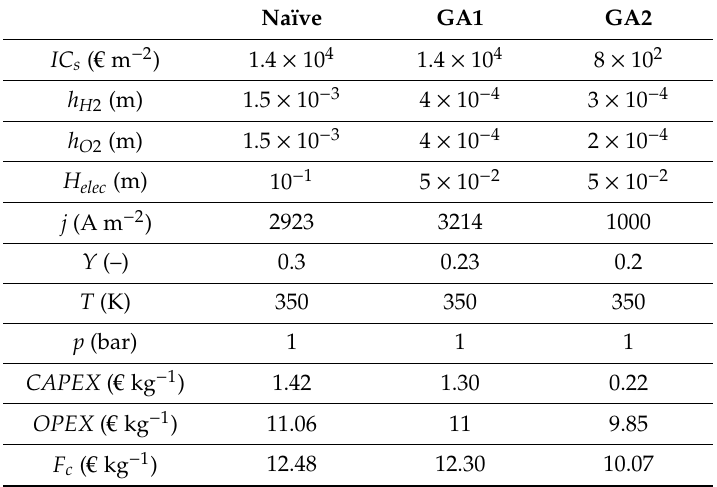
Table 10. Naïve and Optimum DP with their associated hydrogen cost for EC = 17 c € kWh − 1 , r = 25 µ m and R memb = 3.23 × 10 − 5 Ohm m 2 .